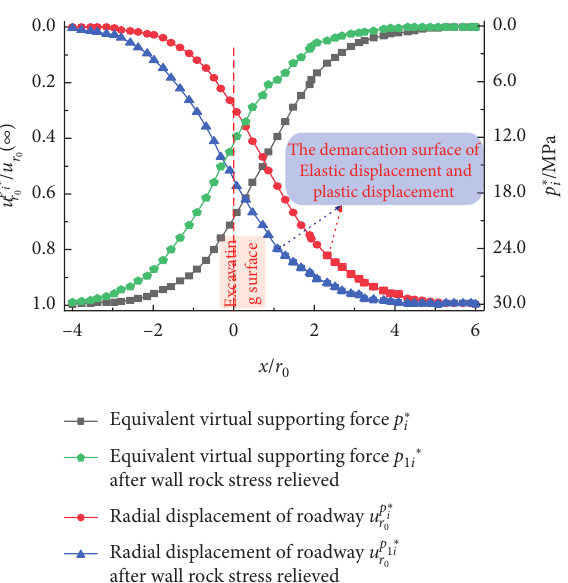
Figure 5: Virtual supporting force and corresponding radial displacement of roadway excavation face.